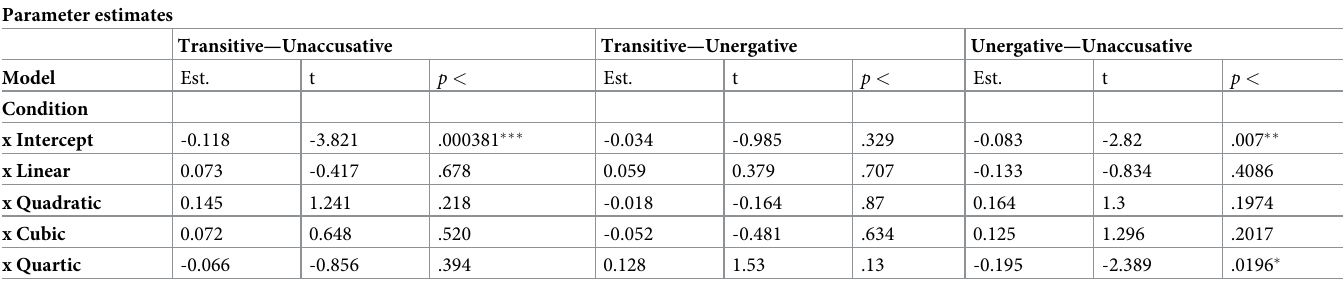
Table 6. Pairwise comparisons of the models of the curves in the verb frame. Parameter